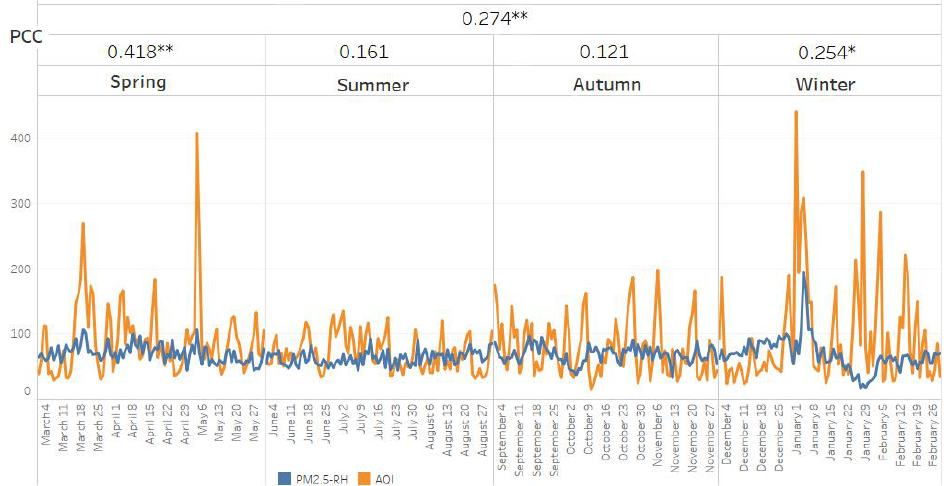
Figure 3. The number of Weibo items about PM 2.5 -RH and the observed AQI in Beijing, from 1 January to 31 December, 2017. Note: Pearson correlation coefficients (PCC). **: significant at the 0.01 level, *: significant at the 0.05 level.